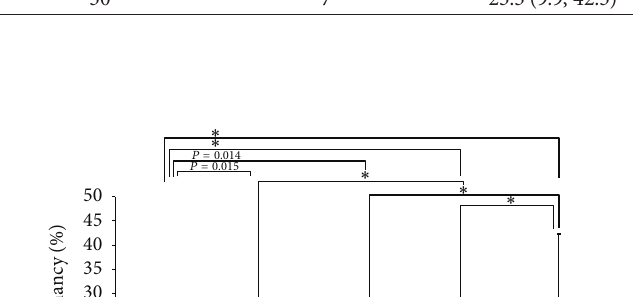
Data in parentheses are 95% confidence intervals.